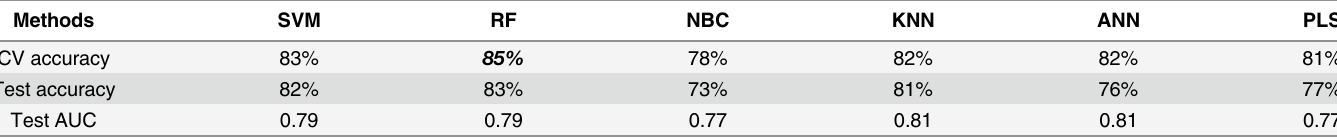
Table 4. dTm binary classification.